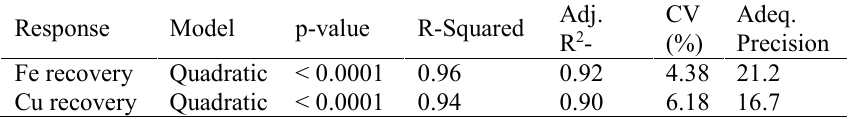
Table 4. ANOVA for the response models